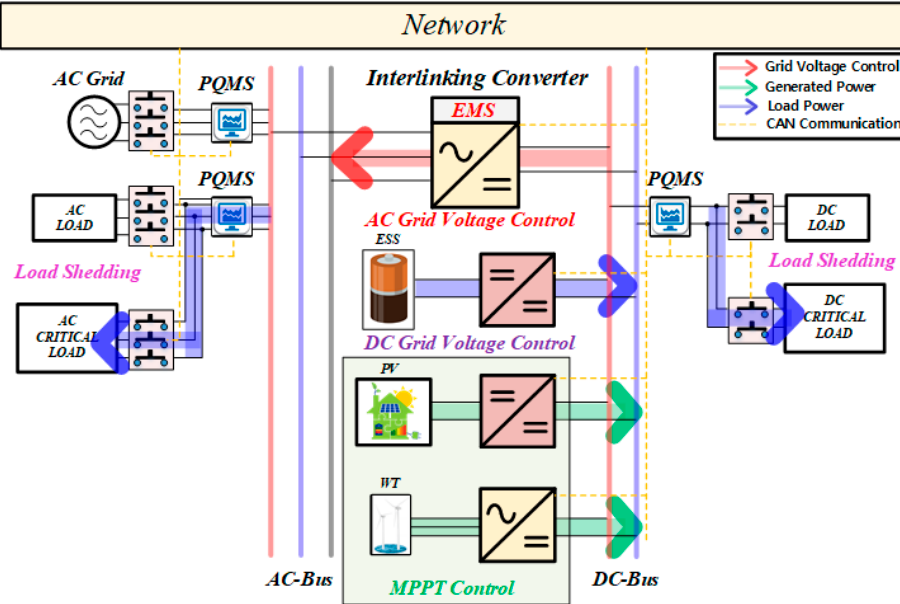
Figure 12. Power flow diagram of the load shedding mode (mode 6).